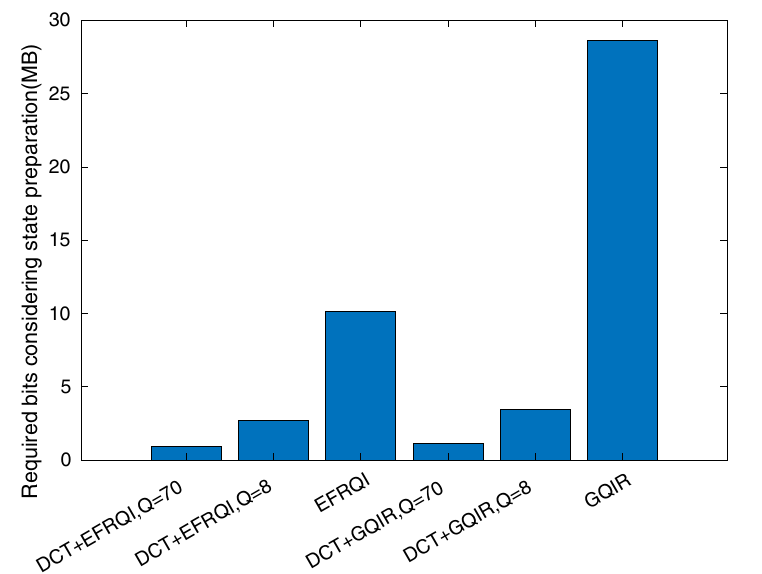
Figure 10. Required bits comparison for deer image.